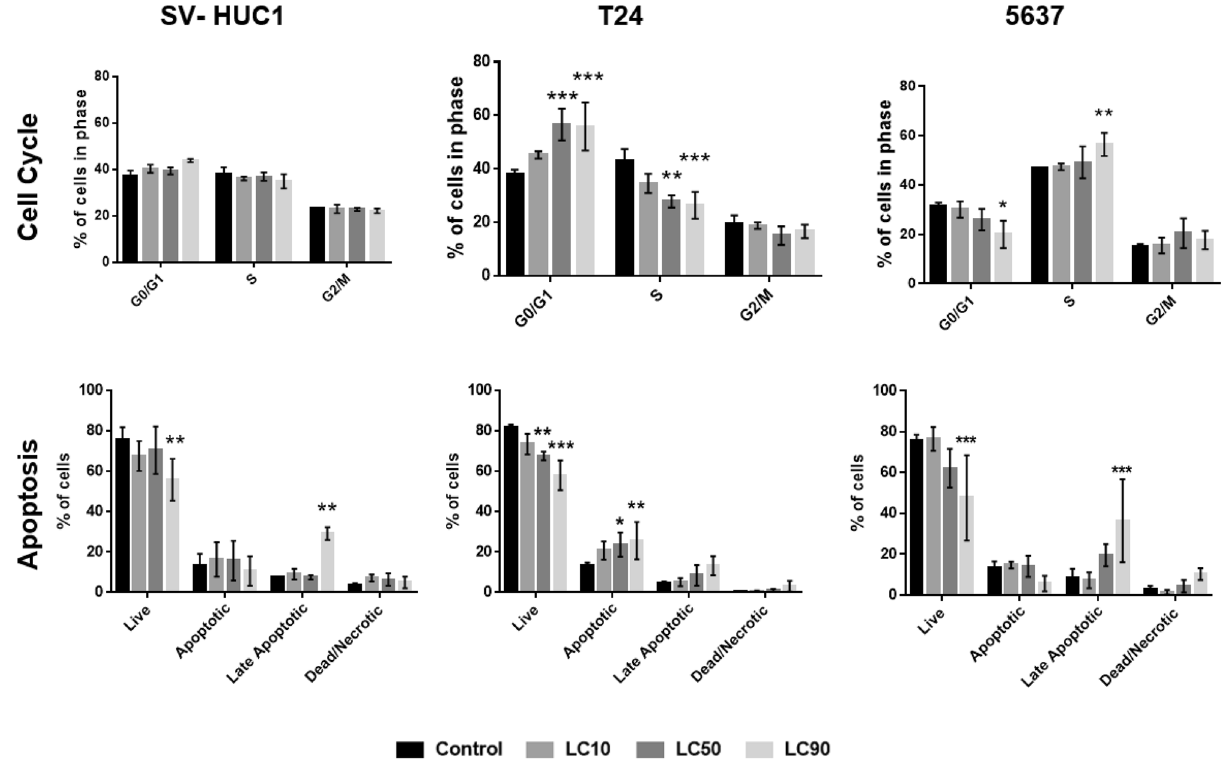
Figure 8. Cell cycle and apoptosis by flow cytometry after cell exposure to their 24 h lethal concentrations of Mumio. Mumio did not affect the cell cycle of SV-HUC1 cells. Increased G0/G1 and decreased S phase cell populations were observed after exposure of T24 cells to LC 50 and LC 90 . Increased cell numbers in G0/G1 phase and S phase were noted in 5637 cells. Apoptosis analysis revealed significantly fewer viable cells with increased late apoptotic cells after exposure to LC 90 of Mumio in SV-HUC1. Significantly fewer viable cells with increased apoptotic cells were observed in T24 cells after incubation with LC 50 and LC 90 of Mumio. SV-HUC-1—normal urothelial cell line, T24—transitional urinary bladder carcinoma cell line, 5637—grade II urinary bladder carcinoma cell line, LC-lethal concentration,* p < 0.05; ** p < 0.01; *** p < 0.001 (compared to